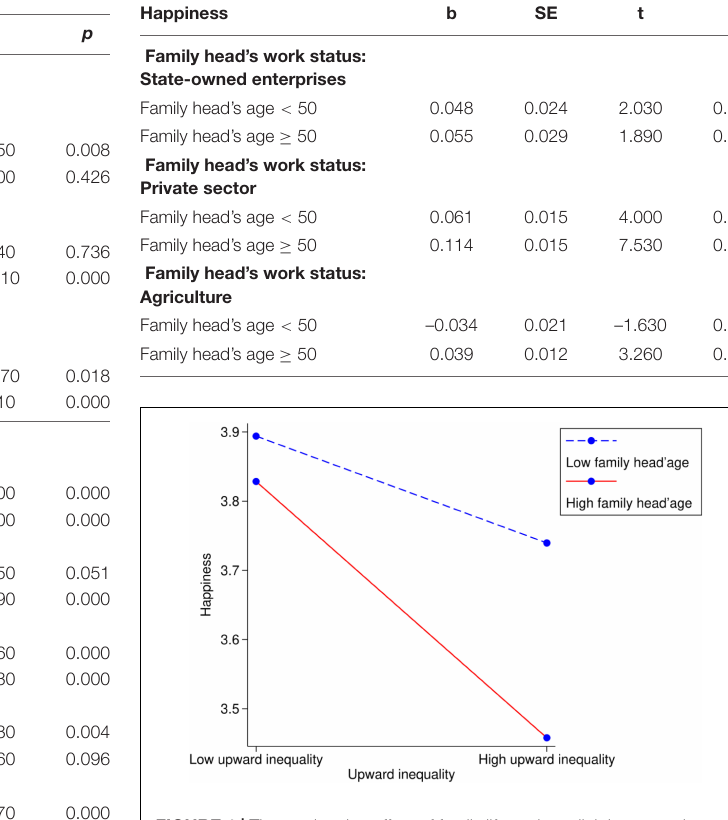
FIGURE 1 | The moderating effect of family life cycle on link between the upward wealth inequality and happiness within young-family-head families (family head’s age < 50).